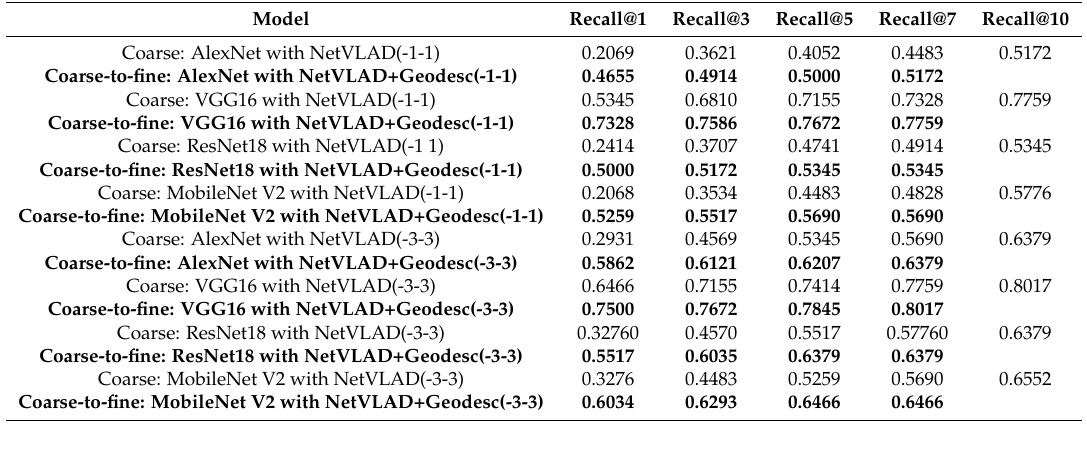
Table 6. Localization results of the coarse-to-fine system on Chengyuan dataset across summer and winter—subset 2 as query and subset 1 as database.